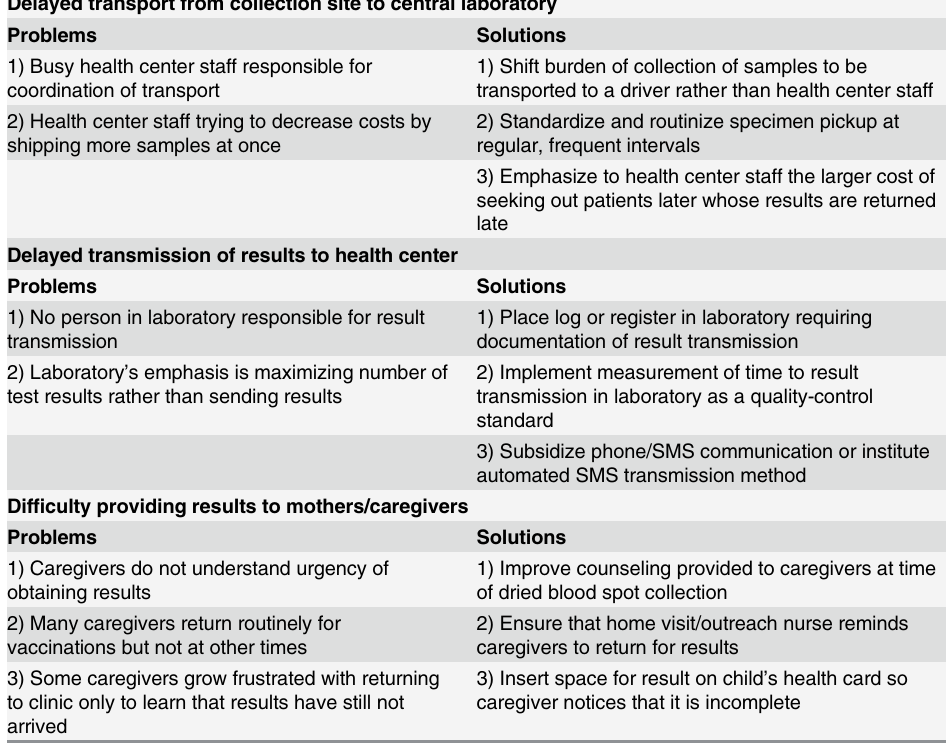
Table 2. Barriers to expeditious dried blood spot testing and potential